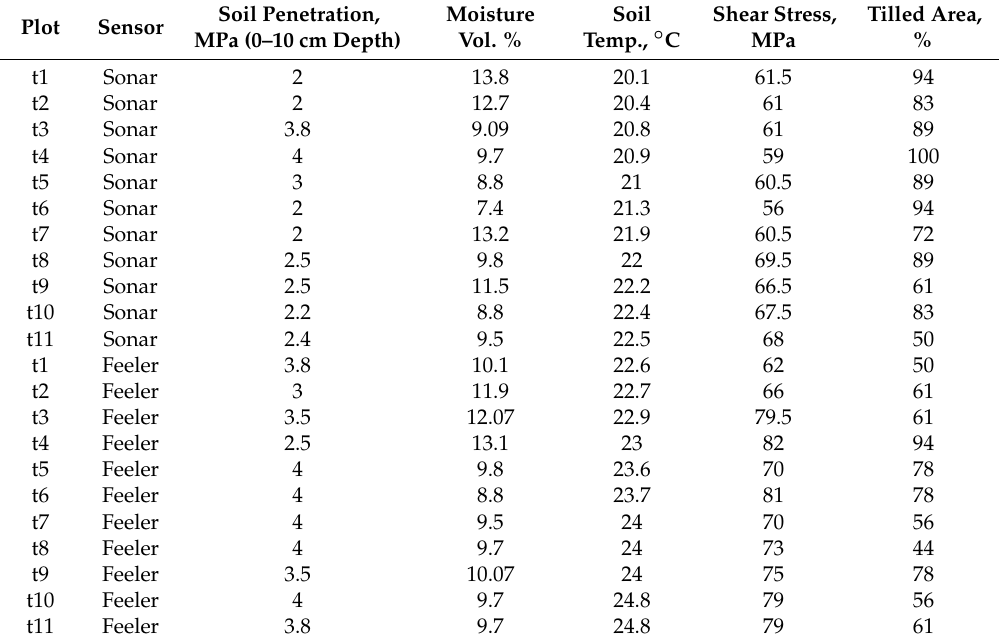
Table 2. Soil physical properties for the evaluation of the sonar and the feeler method in the soil bin and the resulting tilled area (indoor laboratory test).